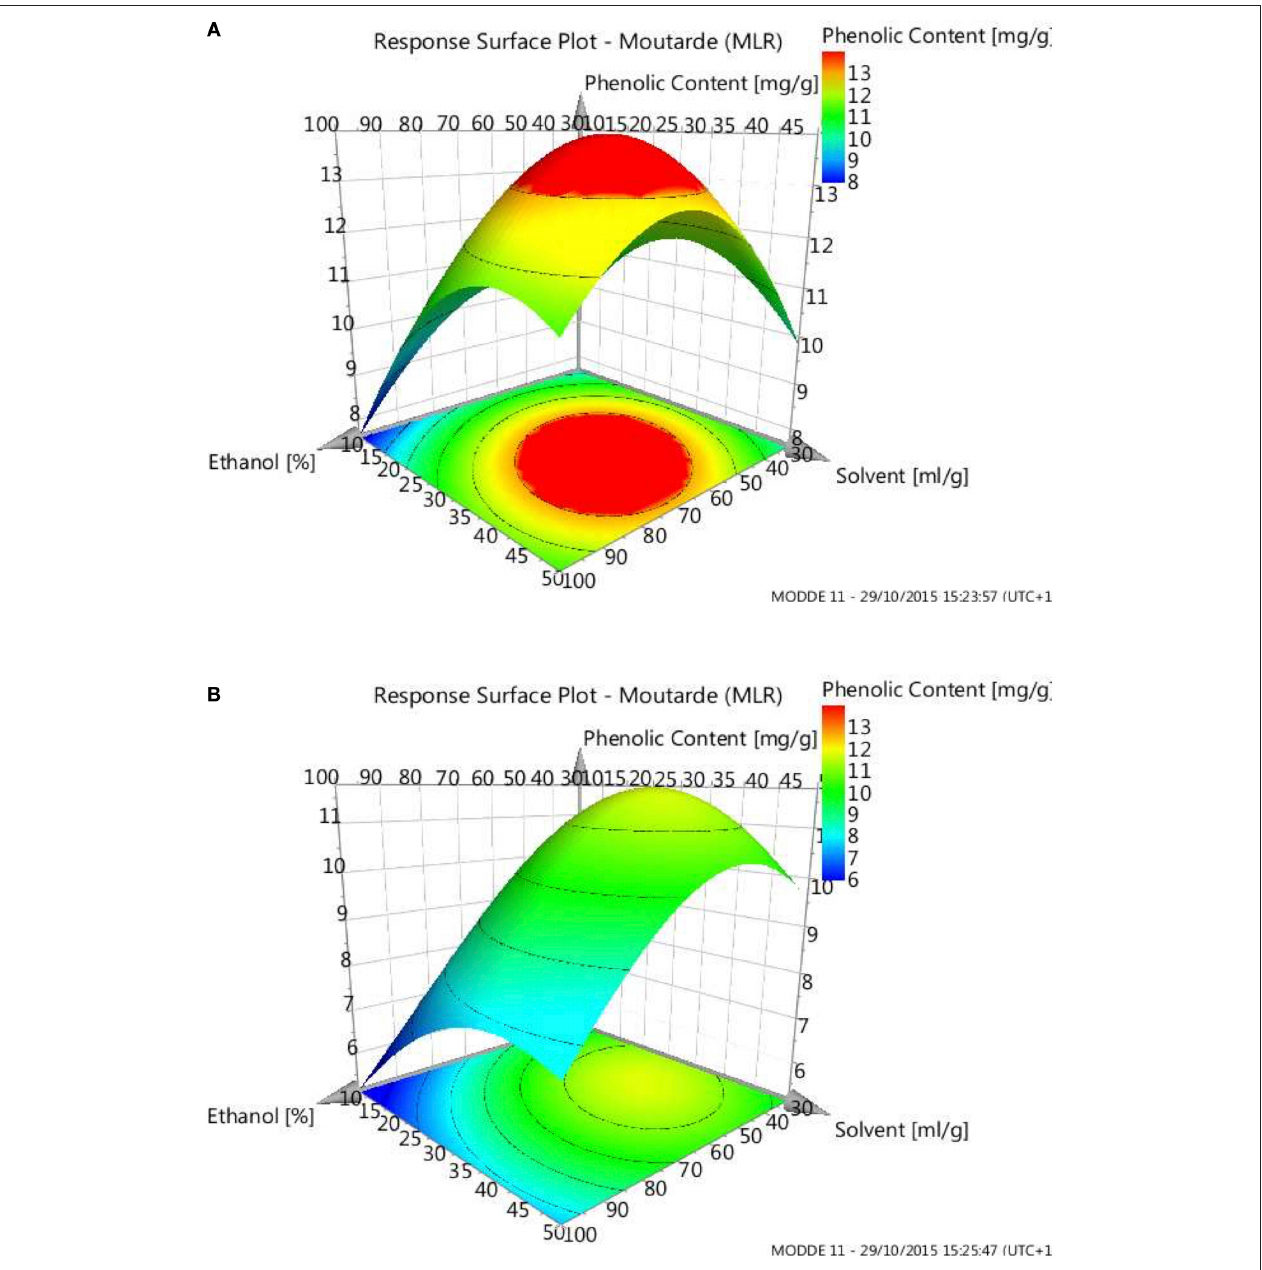
FIGURE 5 | Response Surface Plot at 55 ◦ C and 4h for non-pretreated mustard residue (A) and defatted and dried residue (B) .